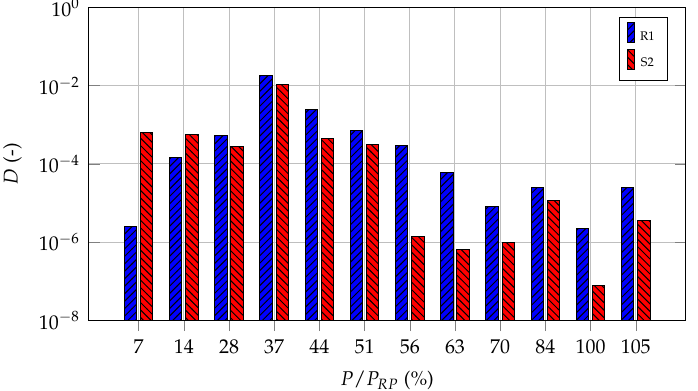
Figure 30. Damage factors at DMS R1 ( left ) and S2 ( right ), close to the hotspots HS1 and HS2 for 1 year operating time.